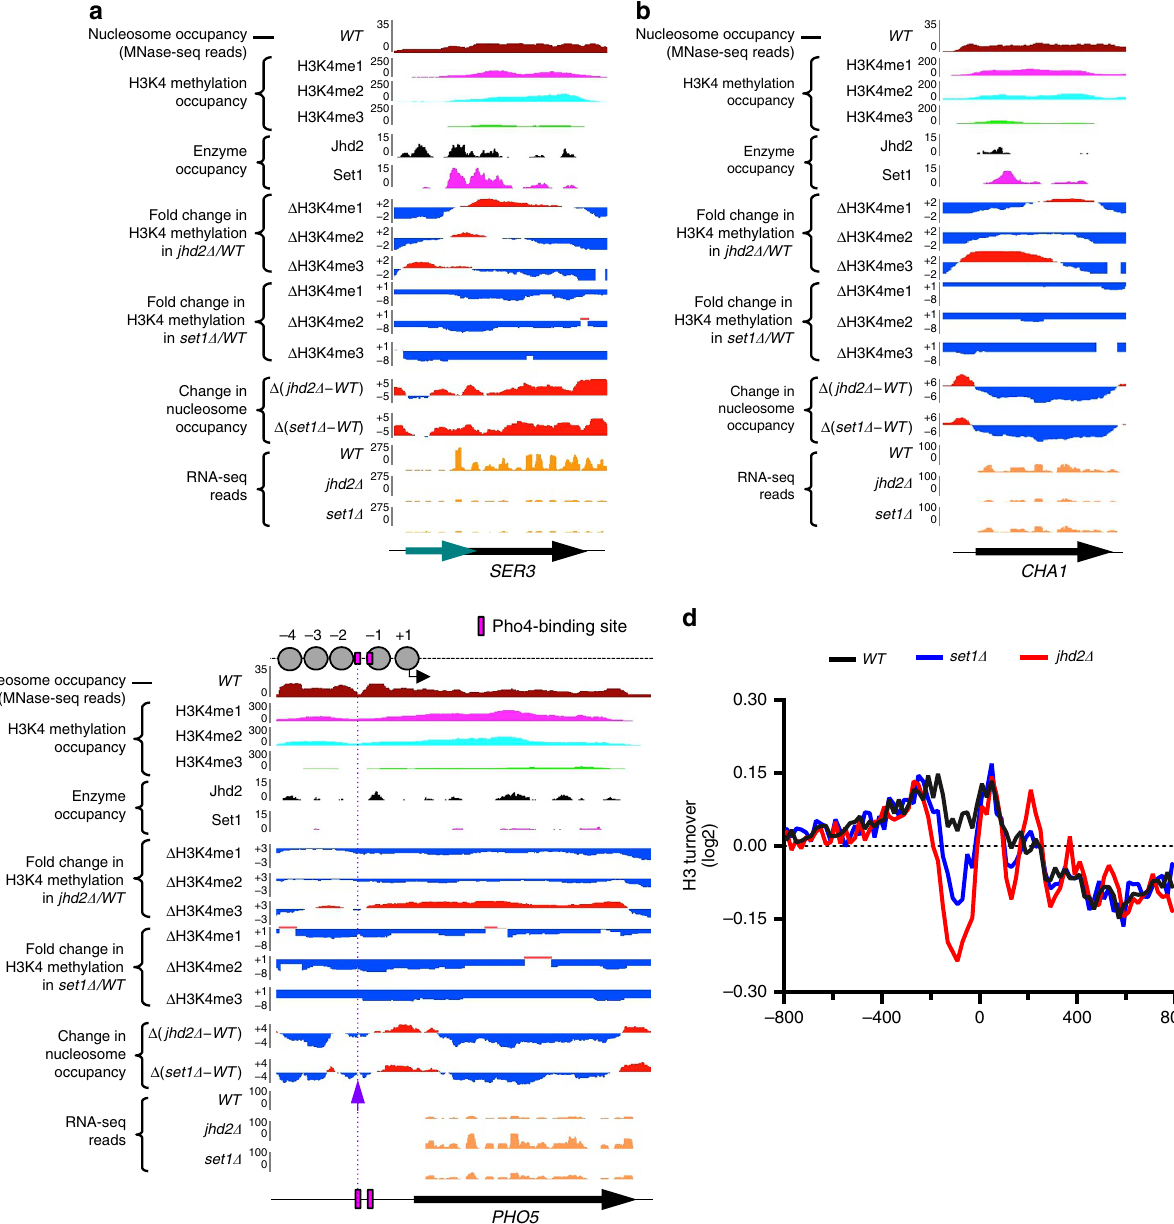
Figure 5 | Co-regulation of nucleosomal occupancy and transcription by Set1 and Jhd2 at candidate target genes. ( a – c ) Changes to H3K4 methylation levels, nucleosomal occupancy and transcripts at SER3 , CHA1 and PHO5 genes in jhd2 D or set1 D are shown. The normal nucleosomal, H3K4 methylation, Jhd2 and Set1 occupancies at target genes are also shown: reads for mononucleosomal DNA in WTshows native chromatin organization (brown). Reads for H3K4 monomethyl (me1, magenta), H3K4 dimethyl (me2, cyan) and H3K4 trimethyl (me3, green) marks in WTshows their distribution over candidate target genes. Enrichment values (qpois) for Jhd2 (black) and Set1 (pink) in WTshow their occupancy at the indicated genes. Fold-change in the levels of H3K4me1, H3K4me2 and H3K4me3 marks in jhd2 D or set1 D relative to that in WTare shown. Fold-change in H3K4 methylation in set1 D relative to WTwas calculated using published datasets 42 . Increase or decrease in a given H3K4 methyl mark in the mutant is shown in red or blue, respectively. Mononucleosomal DNA from WT were subtracted from those obtained from jhd2 D or set1 D and visualized using a genome browser. Gain or loss in nucleosome occupancy in the mutant is represented in red or blue, respectively. RNA-seq reads showing transcript levels for the three target genes in WT , jhd2 D or set1 D strains are shown (orange). Teal arrow indicates SRG1 , a gene coding for regulatory non-coding RNA involved in SER3 regulation 34 . In c , schematic diagram at top shows the nucleosome organization at PHO5 . Circles, well-positioned promoter nucleosomes; black arrow, TSS; and pink box, the Pho4 binding site, determined using published datasets 69,70 . Grape coloured arrow and dotted line indicate decrease in nucleosomal occupancy at the Pho4 binding site. ( d ) The average mean profile for histone H3 turnover across 800bp region upstream ( (cid:2) ) or downstream ( þ ) of the TSSs (0) at all 236 yeast ribosome biogenesis or Ribi genes in WT , set1 D and jhd2 D are